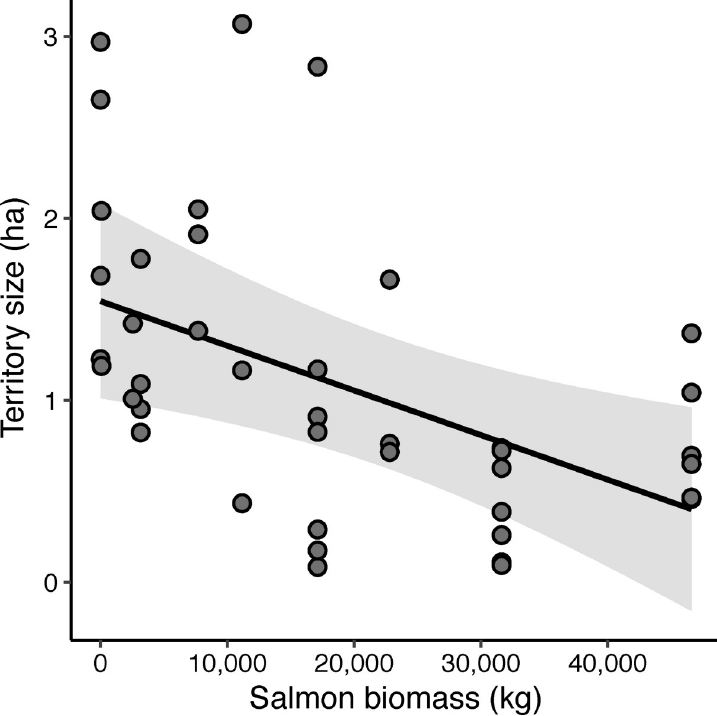
Fig 3. Relationship between the spawning salmon biomass at each stream and male wren territory size in surrounding habitat. The solid line represents the best fit from the top linear mixed-effect model for territory size with all other variables held at their mean. Each point represents an individual male wren’s territory size. The band represents the 95% confidence interval.